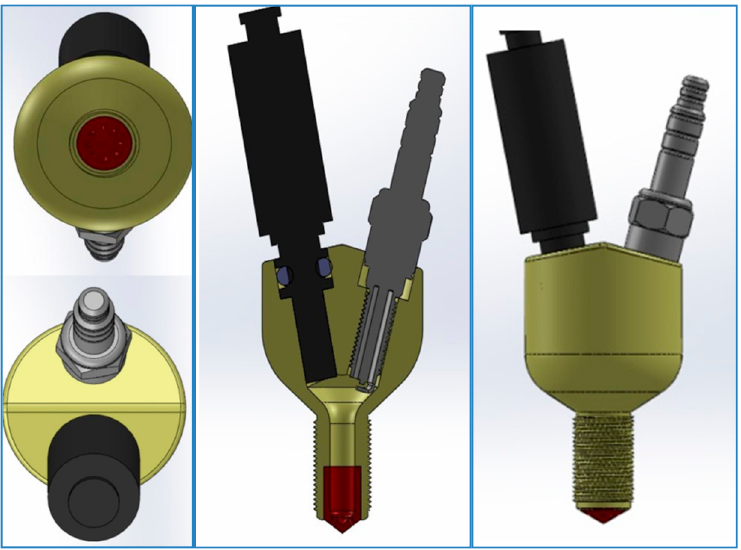
Figure 1. Jet ignition device.